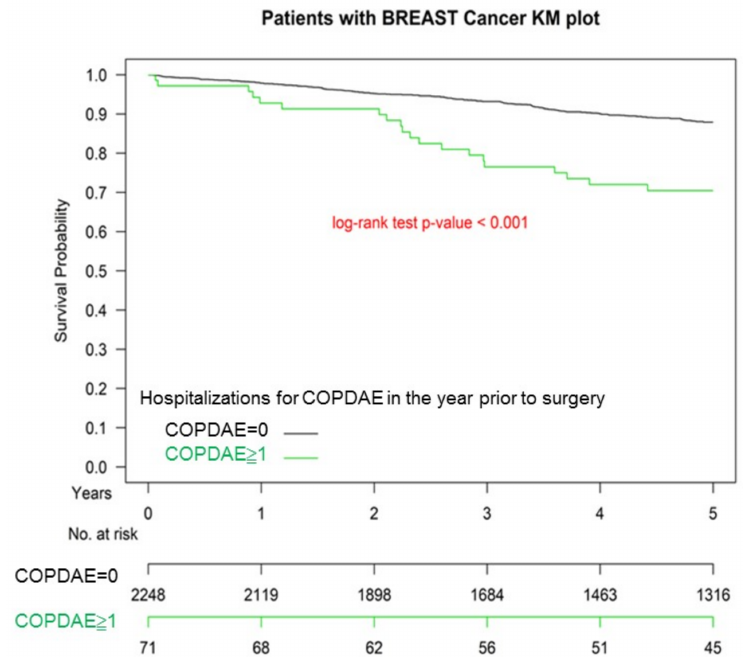
Figure 2. Kaplan–Meier survival curves of patients with invasive ductal carcinoma with frequency of hospitalization for COPDAE within 1 year before breast surgery. COPDAE, chronic obstruction pulmonary disease with acute